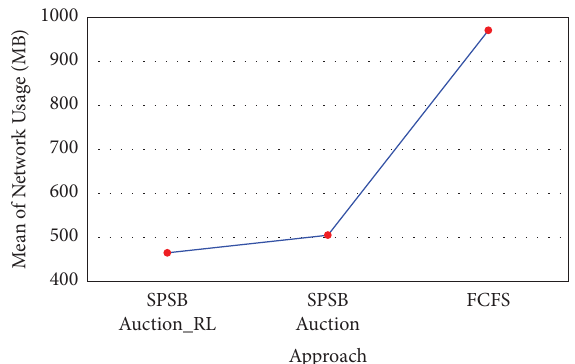
Figure 11: Te average network usage for diferent